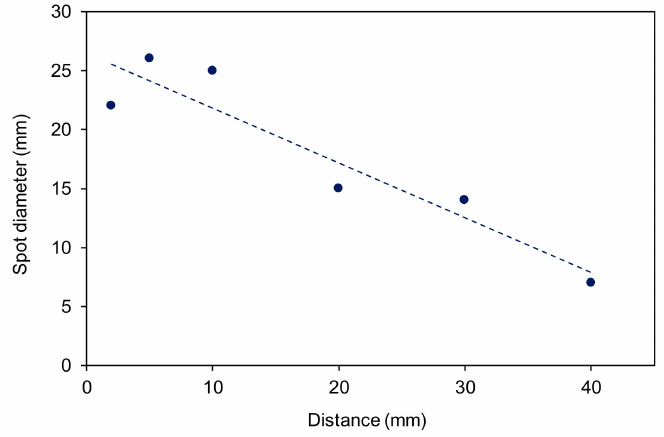
Figure 5. The diameter of the treated zone versus the distance as estimated from Figure